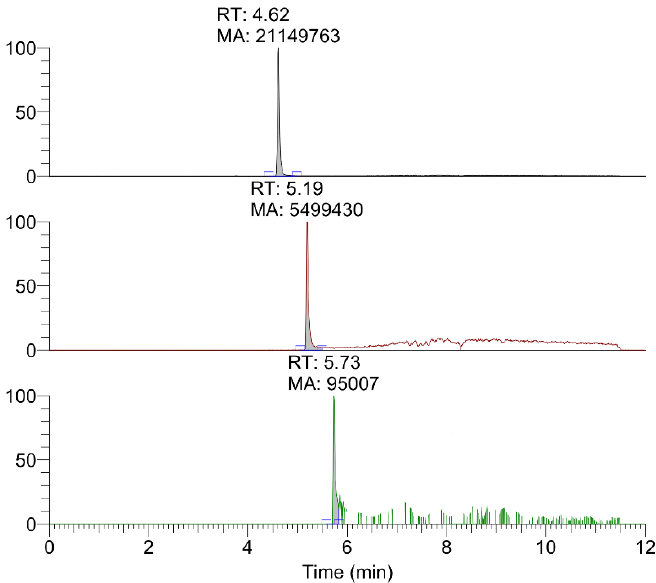
Figure 4. HPLC-HRMS chromatograms relative to non-brominated (top), monobrominated (middle), and dibrominated (bottom) indigoids in the sample DMSO extract.